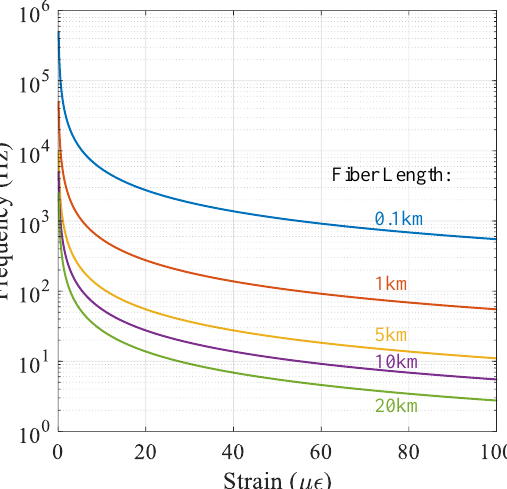
Figure 2. Maximum measurable strain frequency as a function of the strain amplitude for fiber lengths of 0.1, 1, 10, 20 km. The spatial resolution is assumed to be L = 1